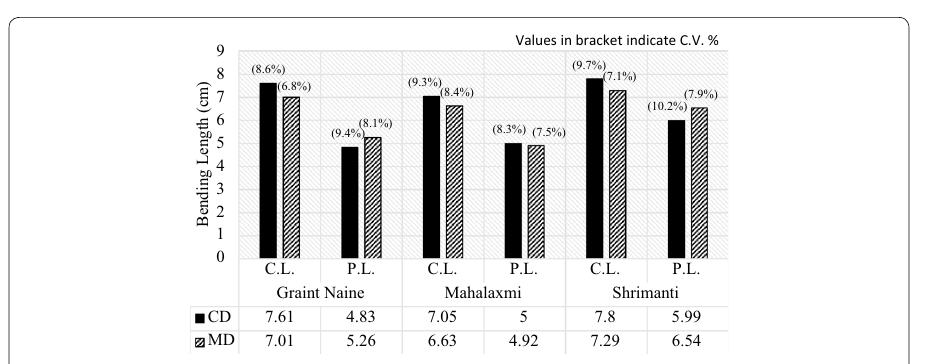
compared to Mahalaxmi non-woven